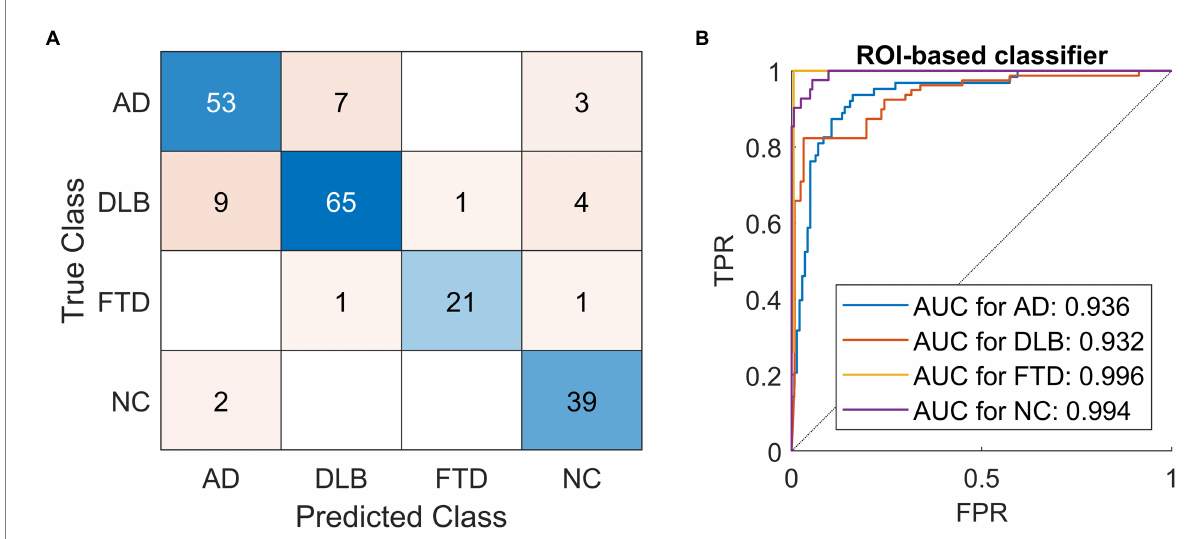
FIGURE 4 The classification results using a region of interest-based support vector machine classifier. A classifier based on 95 regions of interest (ROIs) and multi-class support vector machine (SVM) correctly diagnosed 177 out of 206 cases and achieved 86% overall accuracy. (A) Confusion matrix of labels predicted by the SVM (Predicted Class) compared to gold standard (True Class). (B) One vs. all receiver operating characteristic (ROC) curves for the four possible labels. AD, dementia due to Alzheimer’s disease; DLB, dementia with Lewy bodies; FTD, frontotemporal dementia; NC, normal control; ROI, region of interest; AUC, area under the curve; TPR, true positive rate; FPR, false positive rate.